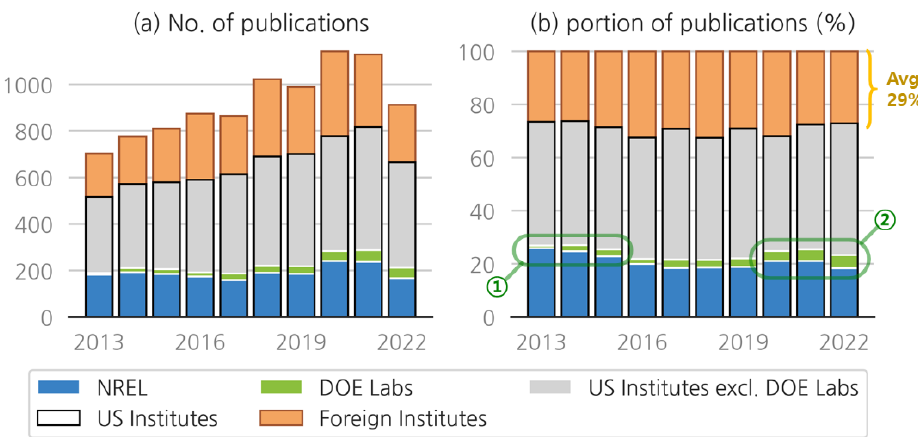
Figure 3. Types of NREL collaborative research (2013~2022). The same data is displayed from two points of view: ( a ) number and ( b ) proportion of publications. “US Institutes” includes publications of the NREL alone or the NREL and DOE together (co-authorship with other laboratories of the DOE), and with other institutions excluding the DOE laboratories but within the United States.